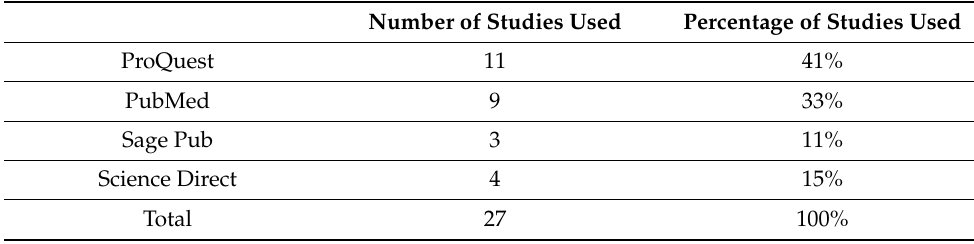
Table 1. Databases and number of studies used in this review.